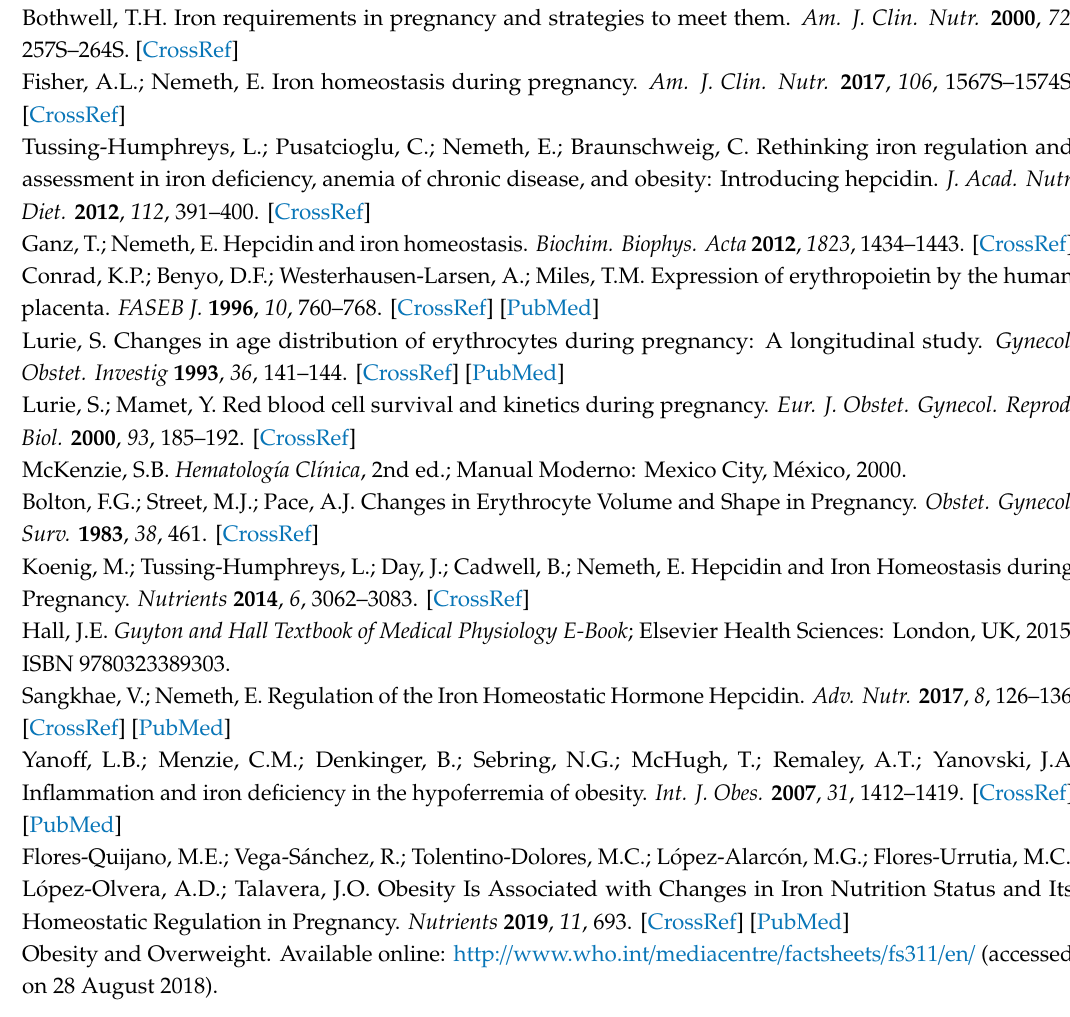
Table S1. Intra-assay coe ffi cients of variation, Table S2. Red cell indices at each study visit, Table S3. Generalized Linear Models for erythropoietin and red cell